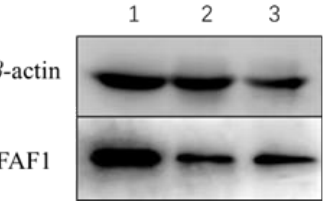
Figure 6. β -actin and FAF1 proteins detected in ovaries of different reproductive cycle phases. 1: Follicular ovary; 2: luteal phase ovary; 3: ovaries during pregnancy.